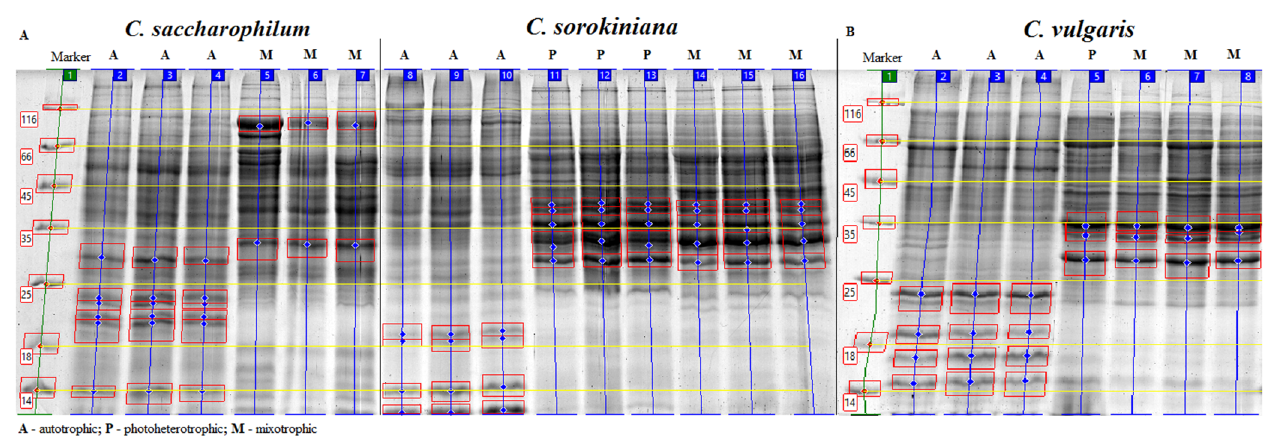
Figure 4. Electropherogram of proteins extracted from C. saccharophilum , C. sorokiniana ( A ), and C. vulgaris ( B ) cells. ( A ): Line 1 mass standard, Lines 2–4 protein lysate from autotrophically cultivated C. saccharophila cells, Lines 5–7 protein lysate from mixotrophically cultivated C. saccharophilum cells,